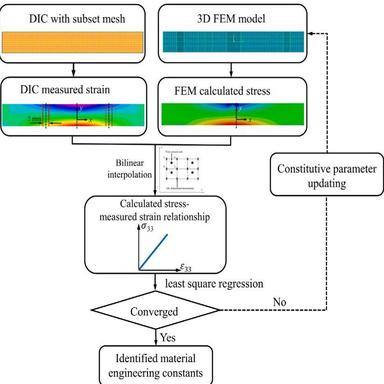
Flowchart of the material constant identification procedure using the DIC data-driven finite-element-model-updating (FEMU) method.